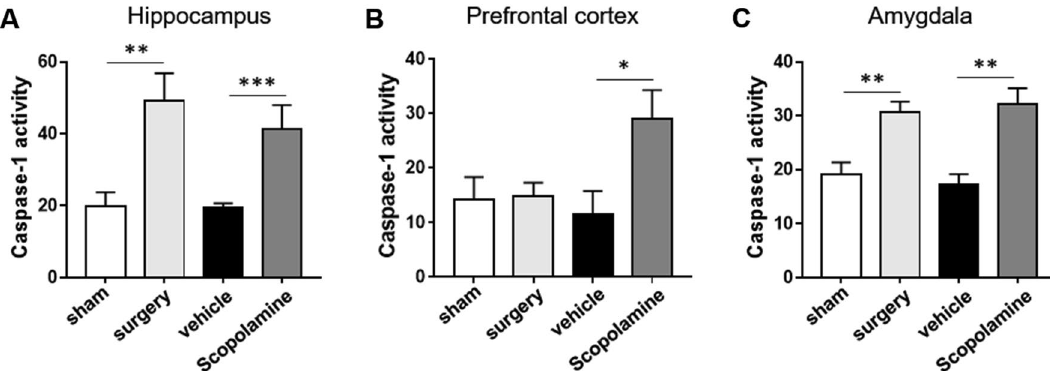
Figure 5. The levels of caspase-1 activity in the brain regions. ( A ) Highly activated level of caspase-1 after surgery (day 5 postsurgery) and scopolamine (3 h after injection) in the hippocampus. ( B ) Increased caspase-1 activation in the prefrontal cortex after scopolamine treatment. ( C ) Increased levels of caspase-1 activity in the amygdala in surgery and scopolamine groups. Values are presented as mean ± SEM (n = 5). p values < 0.05 were considered significant ( *p < 0.05, **p < 0.01, ***p < 0.001 vs. control (sham or